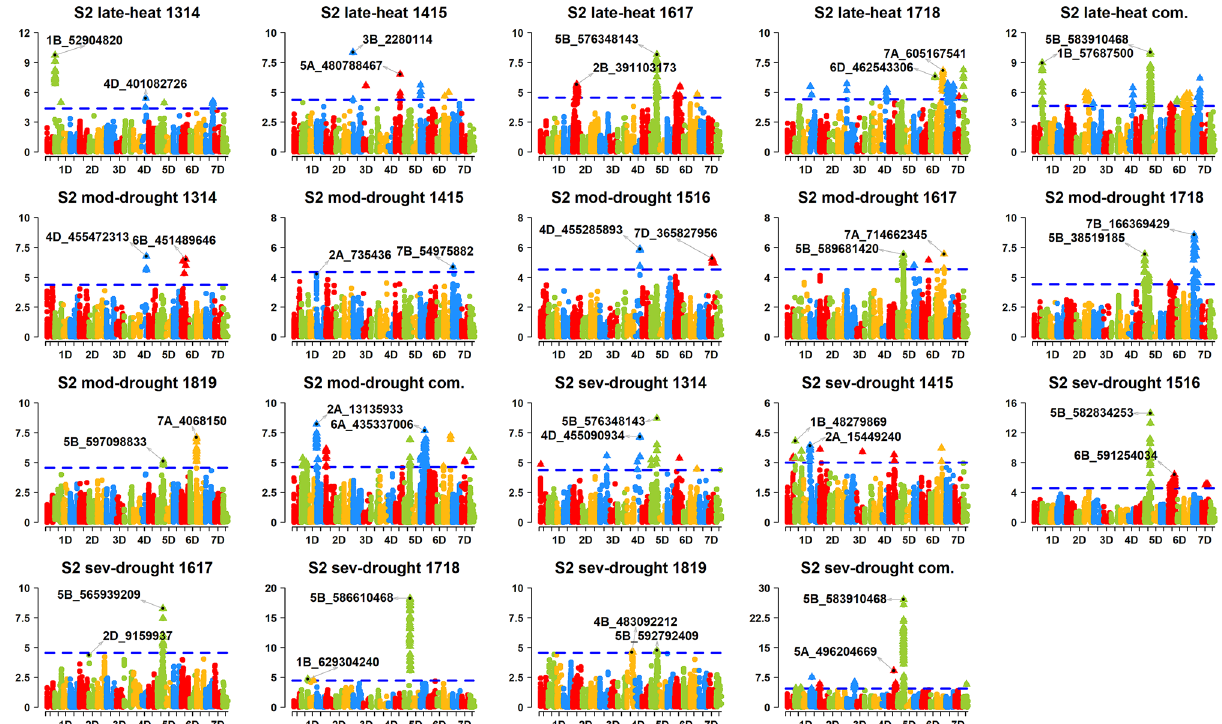
Figure 4. Markers significantly associated with grain yield in the Stage 2 (S2) yield trials evaluated in the late- heat (S2 late-heat), moderate-drought (S2 mod-drought) and severe-drought (S2 sev-drought) environments at Obregon (Mexico), during the 2013–2014 (1314), 2014–2015 (1415), 2015–2016 (1516), 2016–2017 (1617), 2017–2018 (1718) and 2018–2019 (1819) crop cycles and in the combined (com.) analysis across crop cycles. The chromosomes are shown in the x-axis and the − log 10 p values in the y-axis. The threshold lines correspond to the threshold using the Bonferroni correction for multiple testing at an α level of